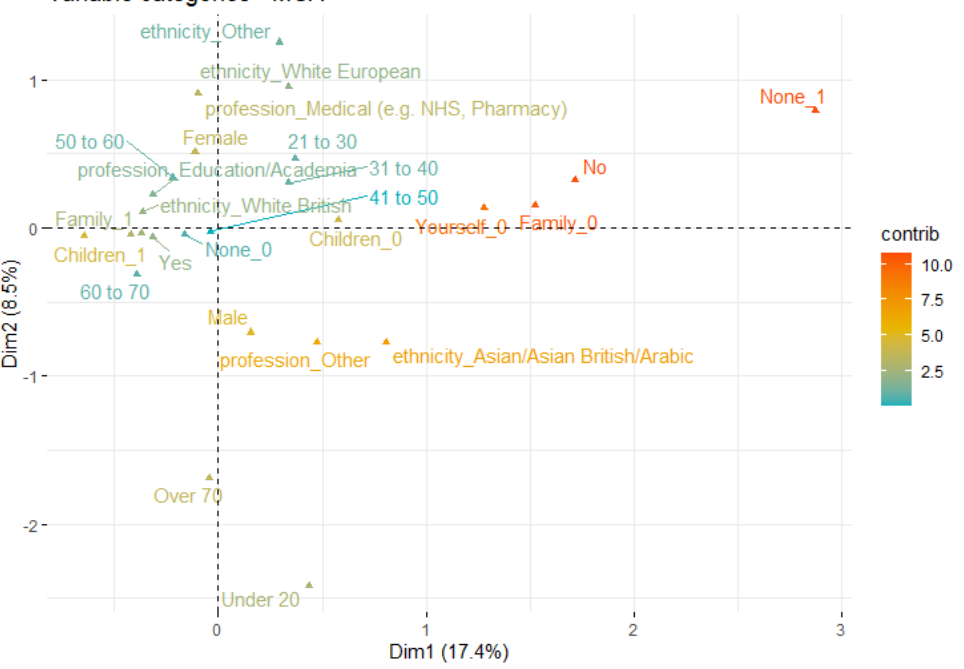
Figure 6. MCA outcomes (first two dimensions) for the combined visualisation of vaccination acceptance and sociodemographic attributes (ethnicity, profession, sex, and age groups).